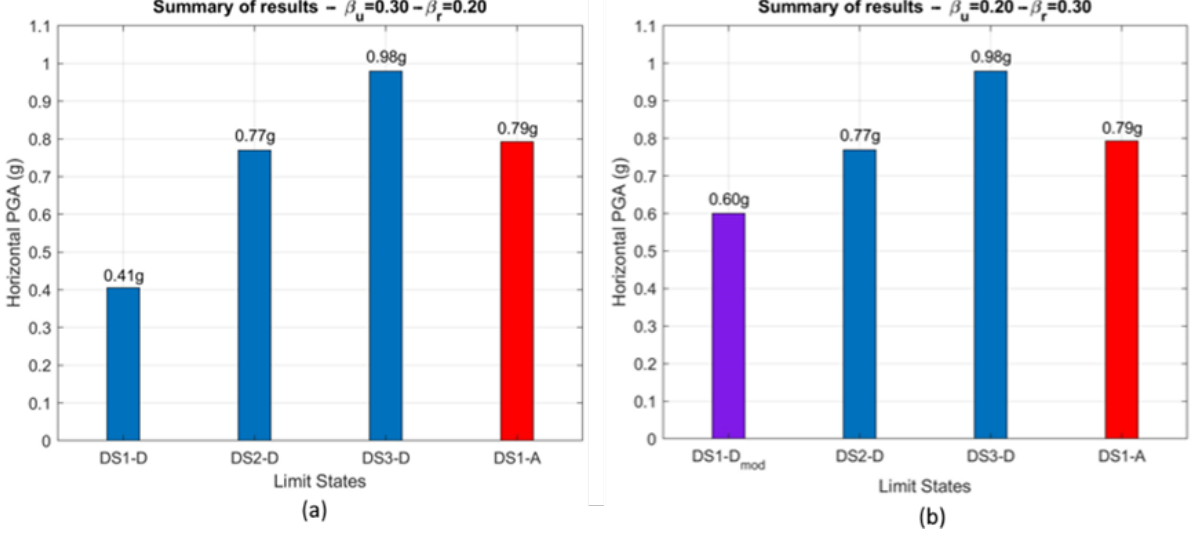
Figure 15. Fragility curves results for both limit states for ( a ) original pipeline LS (DS1-D), ( b ) modified pipeline LS (DS1-D mod ).